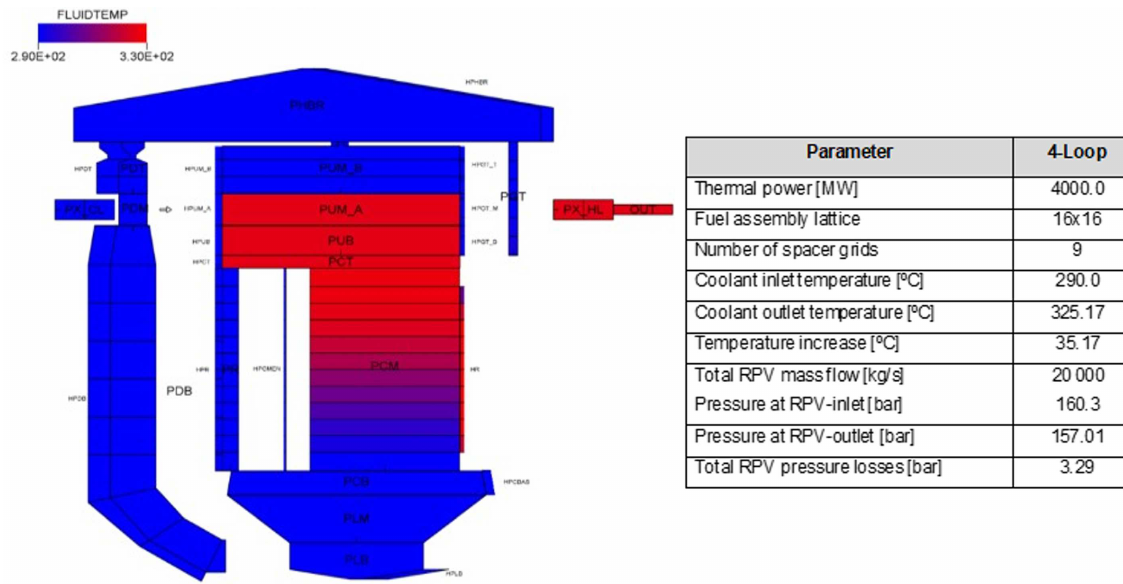
Fig. 9. Automatically generated model of RPV (KWU reactor type) by the AMG tool using ATHLET-code and thermal- hydraulic parameters calculated by ATHLET using the RPV-model.